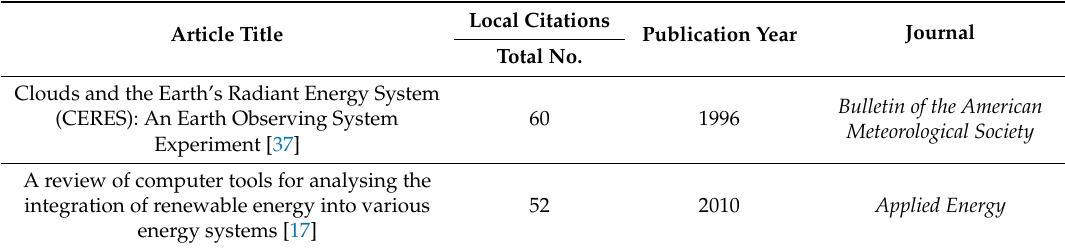
Table 8. Six most frequently cited references in the articles on municipal energy system